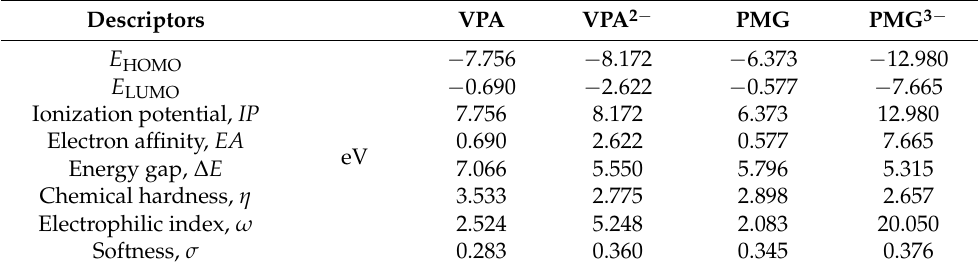
Table 4. The calculated electronic properties of the studied